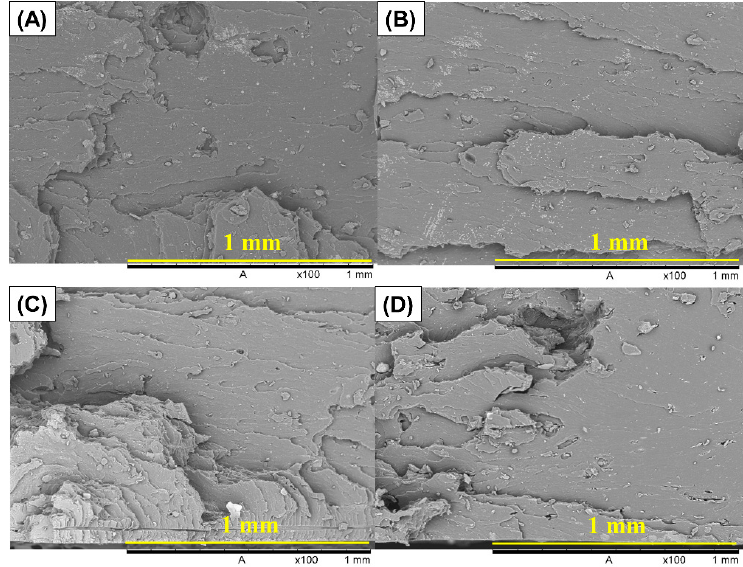
Figure 12. Scanning electron microscope (SEM) images of the tensile fracture surfaces of NR / HNT composites in the presence of MNR / HNT as dual compatibilizers: reference ( A ), MPS 0 phr ( B ), MPS 0.5 phr ( C ), and MPS 1.5 phr ( D ), all at 100 ×